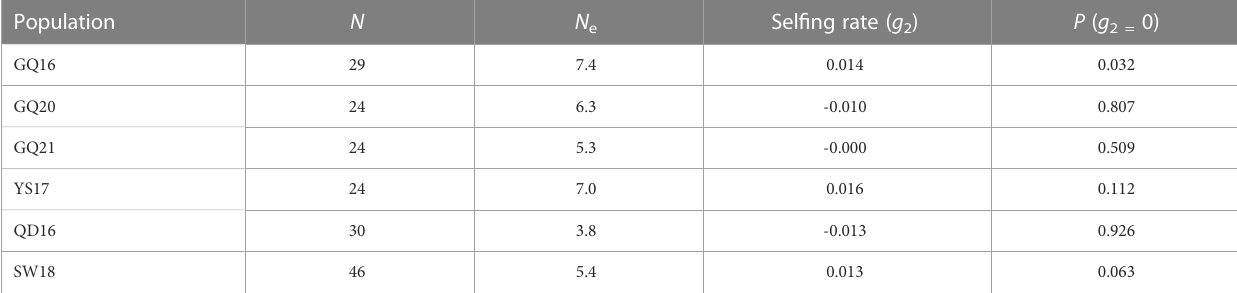
TABLE 4 Number of effective alleles and sel fi ng rates of the native populations of Undaria pinnati fi da from southern China and the control subtidal natural populations from northern China.